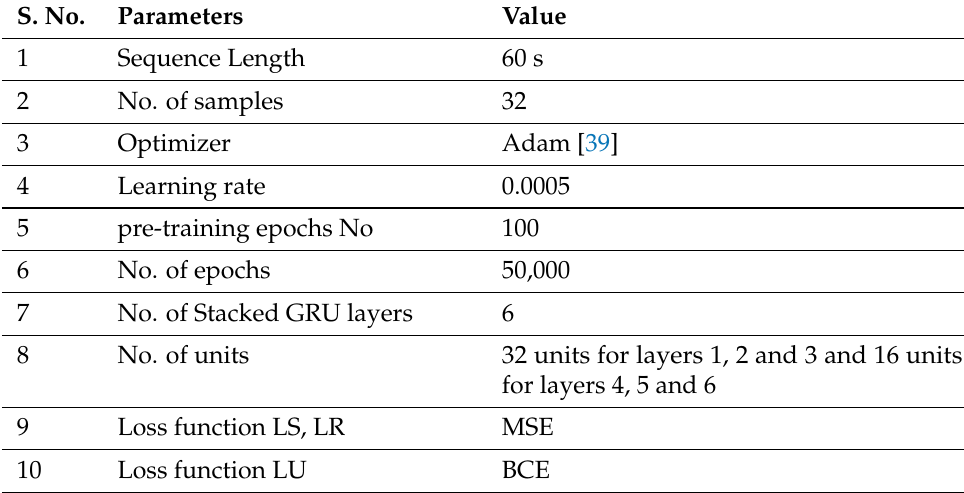
Table 4. Training parameters of